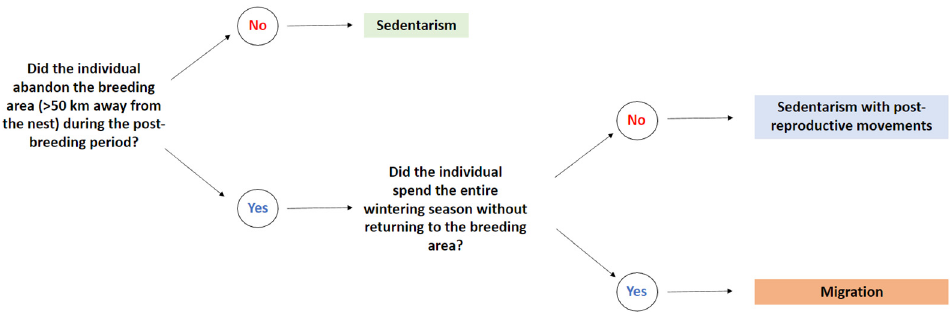
Figure 1. Qualitative classification criteria to delimit the three post-reproductive strategies.